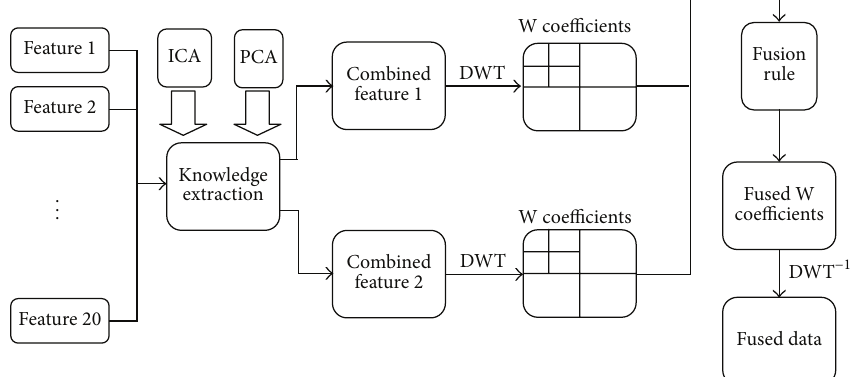
Figure 16: Multiresolution decomposition based data fusion algorithm diagram; DWT and DWT −1 : wavelet multiresolution decomposition and its